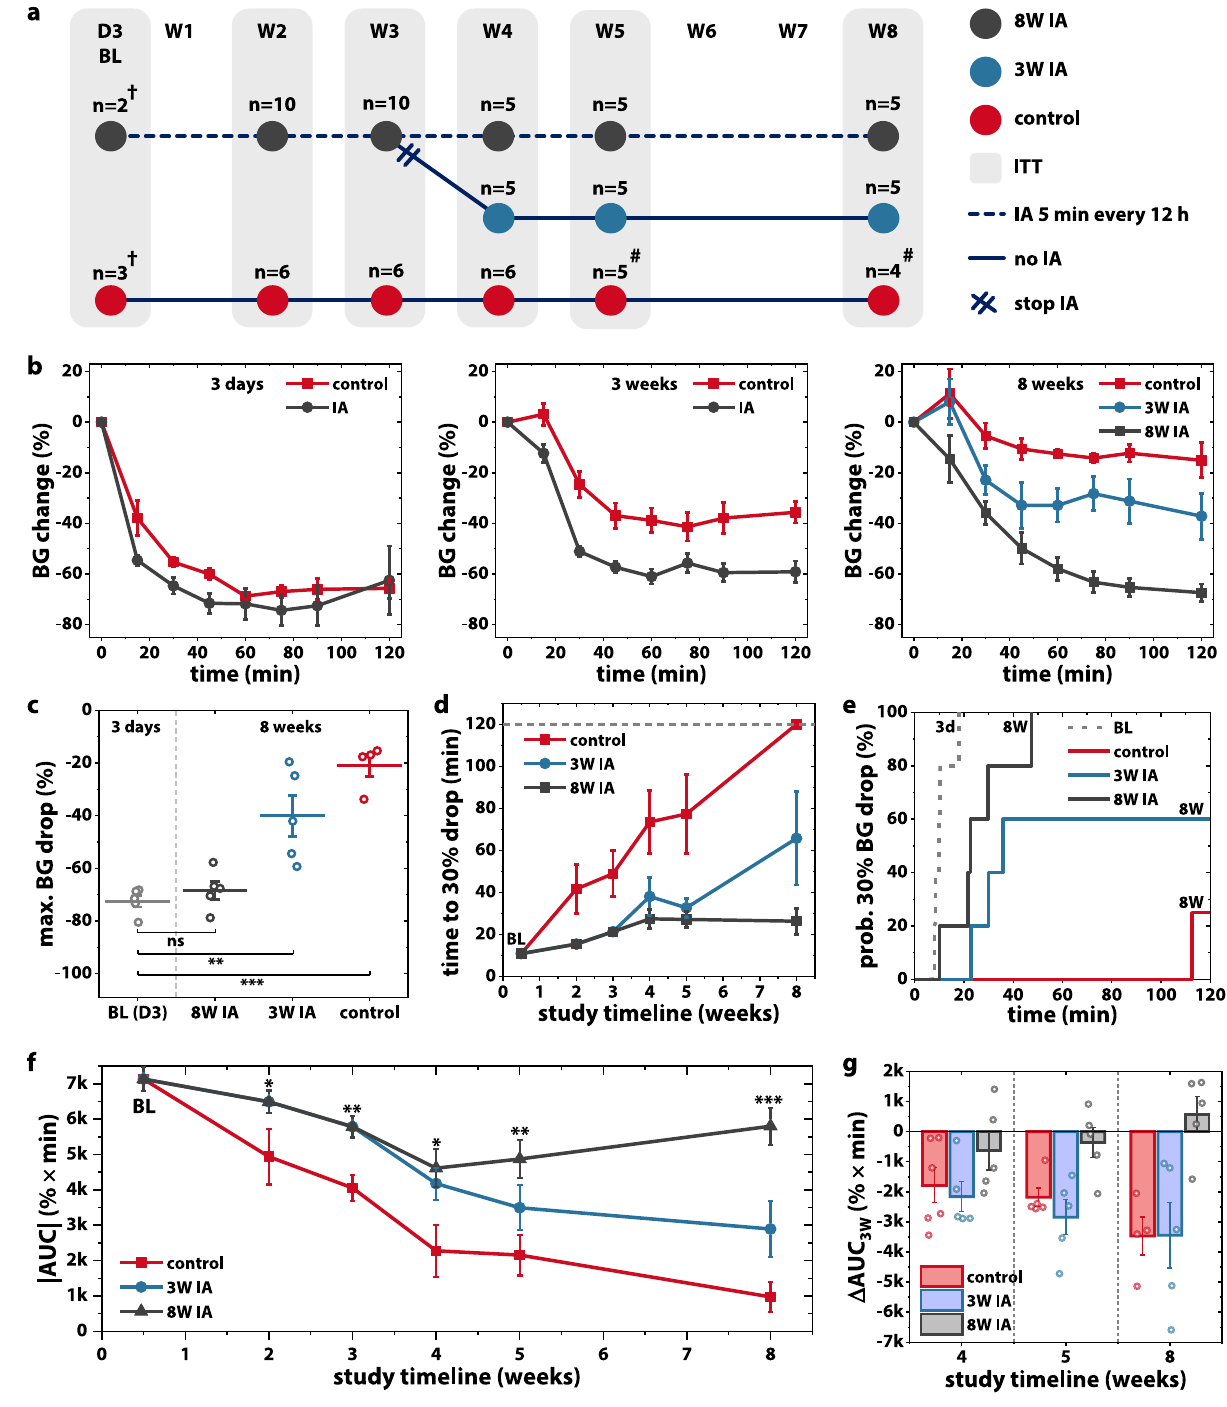
Fig. 3 | Intermittent actuation (IA) improves long-term macromolecule deliv- ery.a PreclinicalstudytimelineusedtoevaluatetheeffectofIAoninsulintransport through a fi brous capsule. b Blood glucose (BG) response to human insulin, mea- suredover120minatday3(baseline),week3andweek8. c MaximumBG%change at the 8-week timepoint. d Time to achieve a 30% drop in BG level, measured longitudinally. e Cumulative incidence curves demonstrating probability of achieving a 30% BG drop over 120min for all groups at both baseline (3 days) and